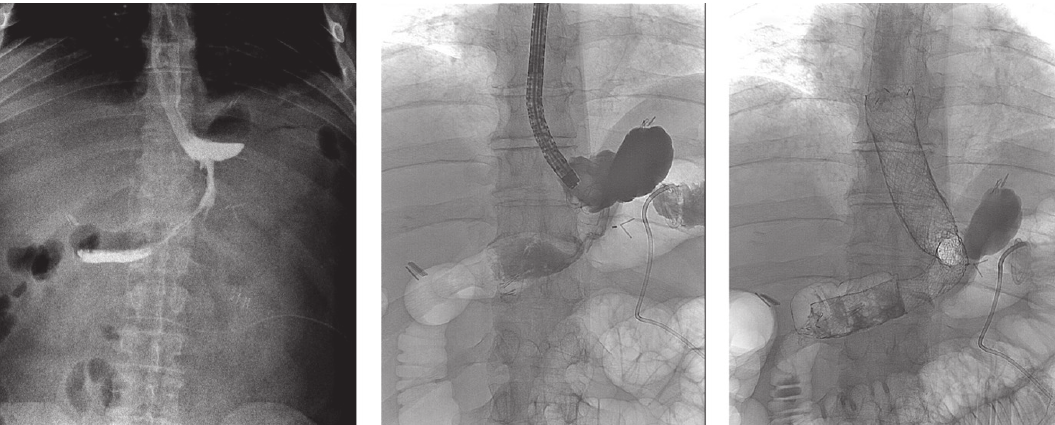
Figure 2: Male, 34 years, BMI 43 Kg/m 2 . Evidence of leak in radiological upper gastrointestinal series; confirmation of the leak with fluorescence endoscopy; endoscopic gastrooesophageal